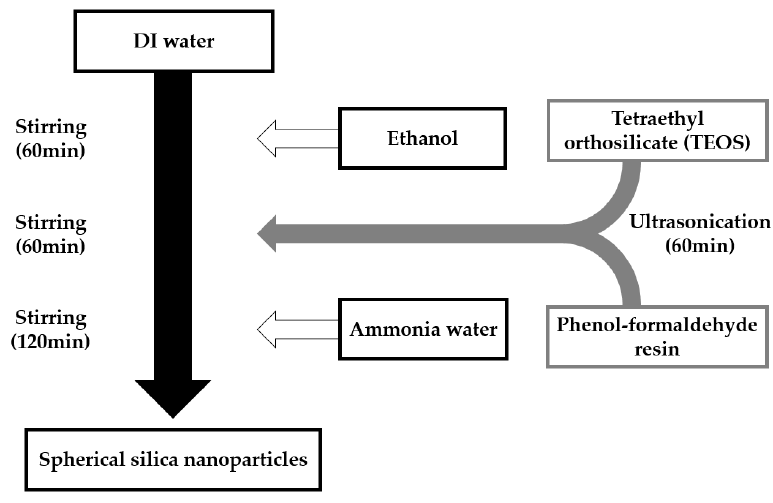
Figure 1. The manufacturing process for silica nanoparticles. Table 1. Reagents used in the synthesis of spherical silica nanoparticles.